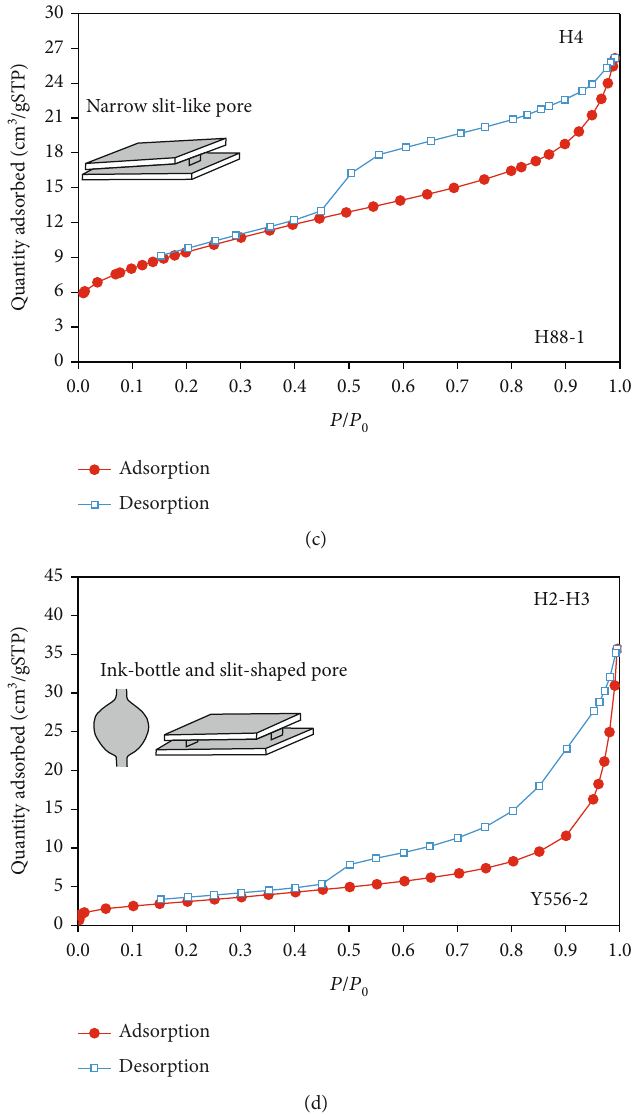
Figure 3: Nitrogen adsorption-desorption isotherms of